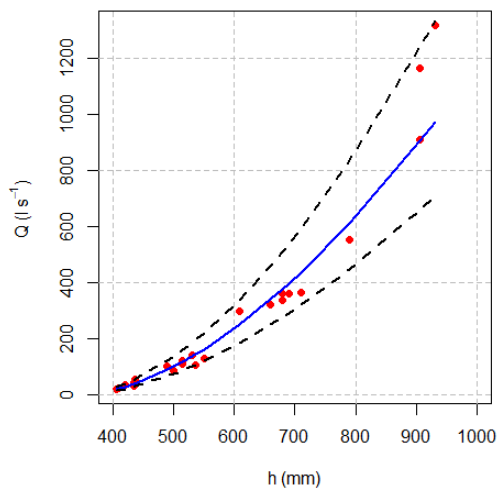
Figure 3. Rating curve in Kervidy–Naizin; acceptability bounds de- rived from 90% prediction interval (blue line: fitting regression; black dashes: 90% prediction interval). Red dots represent the orig- inal discharge measurements used to calibrate the stage–discharge rating curve (Carluer,